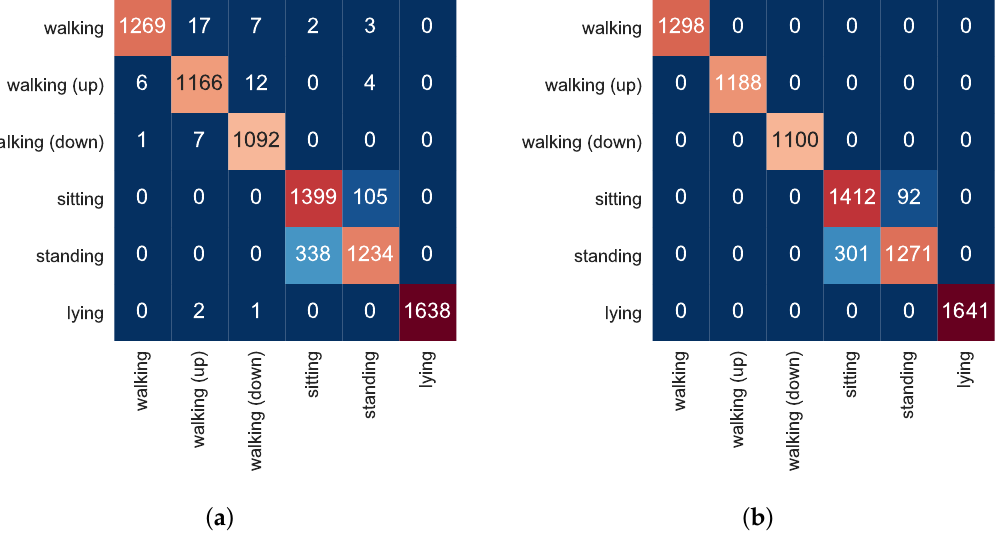
Figure 11. Contingency tables of activities recognised on the HAR dataset with Linear Regression (LR) ( a ) and LR with Conditional Random Fields (CRFs) ( b ) with a window length of 3 s, and a sampling rate of 20 Hz. Rows indicate the ground truth and columns indicate predictions. ( a ) Contingency table for LR. ( b ) Contingency table for LR +